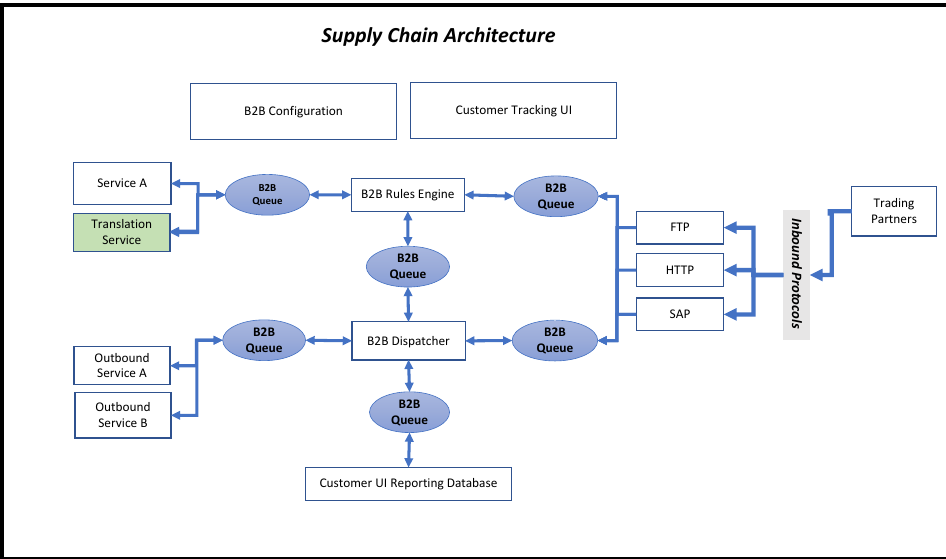
Figure 1. Supply chain network architecture.